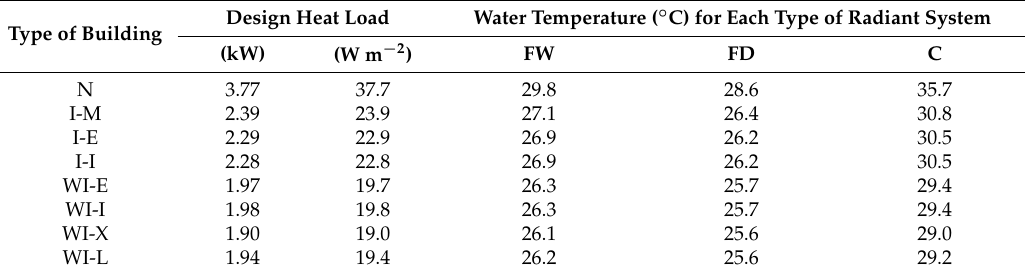
Table 4. Design heat load, specific heat load (per floor area) and supply water temperature evaluated considering a water temperature drop of 5 ◦ C.